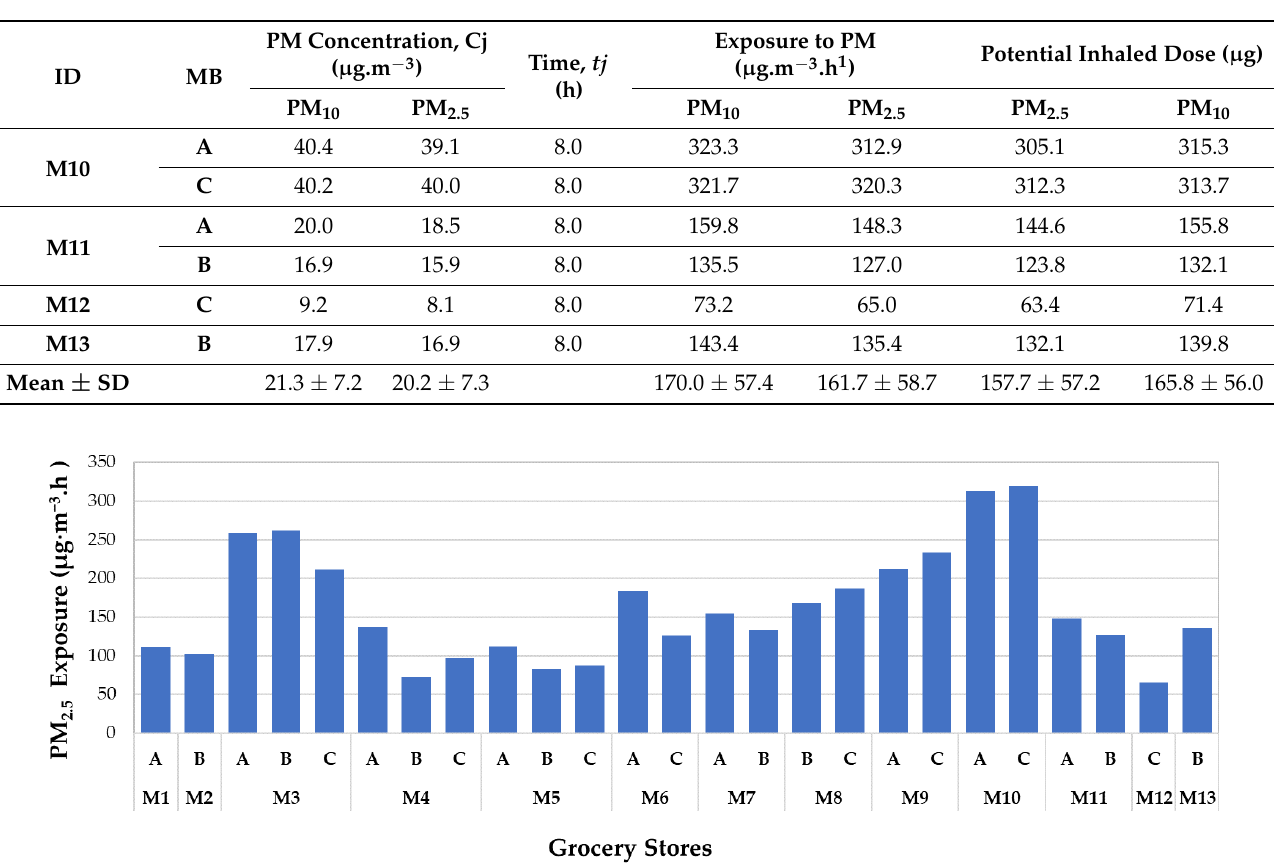
Figure 8. PM 2.5 exposure levels of workers at all studied locations of the GSs, considering a working period of 8 h.